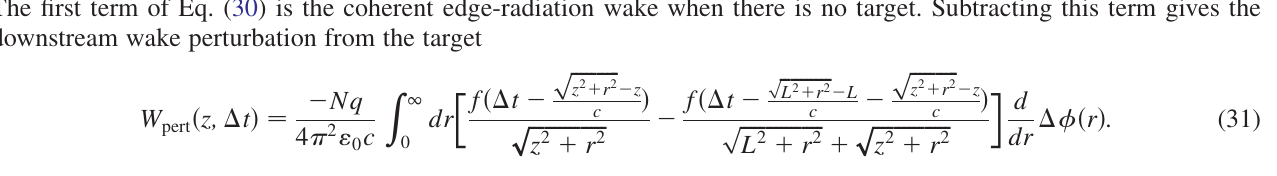
ffiffiffiffiffiffiffiffiffiffi p z 2 þ r 2